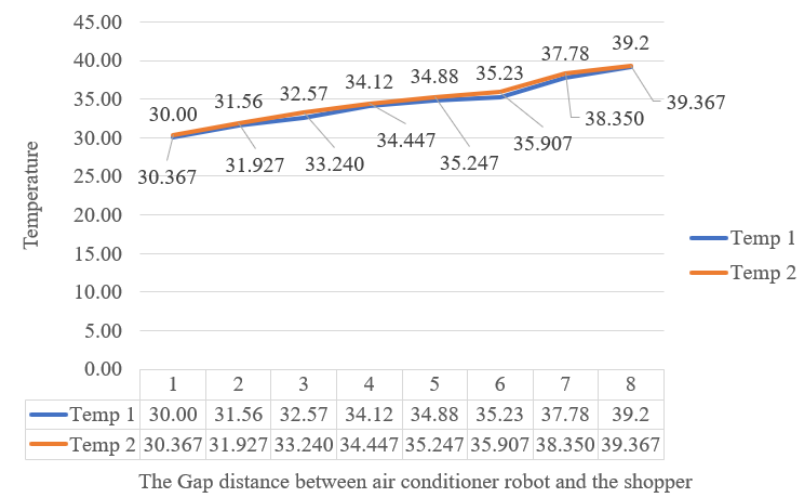
Figure 20. Schematic of experiment and airflow display